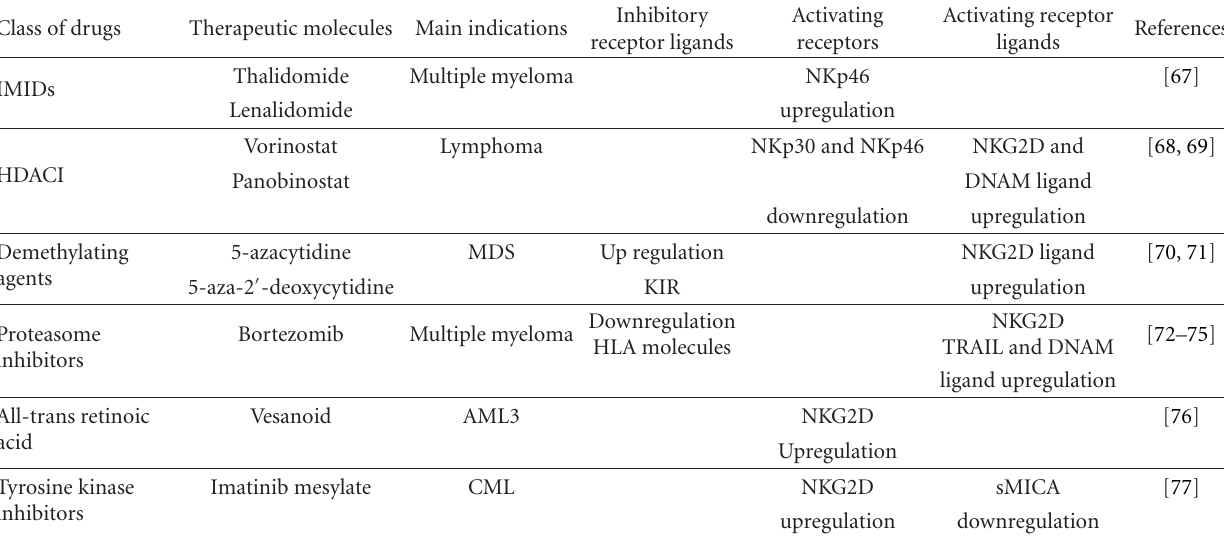
Table 2: Novel agents used in hematological malignancies and their impact on NK-cell activation. Class of